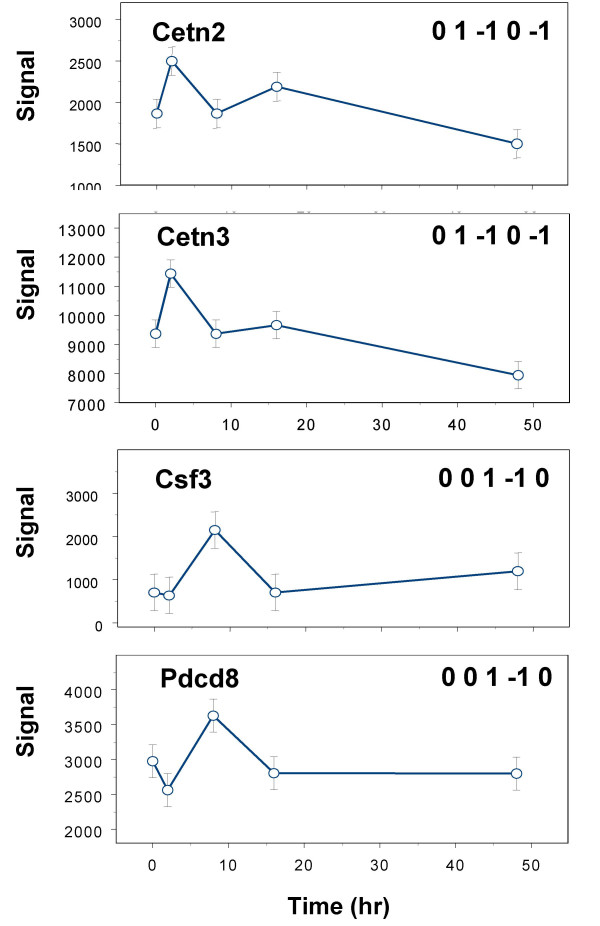
Genes shared the same expression pattern were grouped together. Expression patterns of genes Cetn2 and Cetn3 from Class I are the same and therefore they were grouped together. Another example is genes Csf3 and Pdcd8 from Class II which were put into one group because of the same expression pattern.